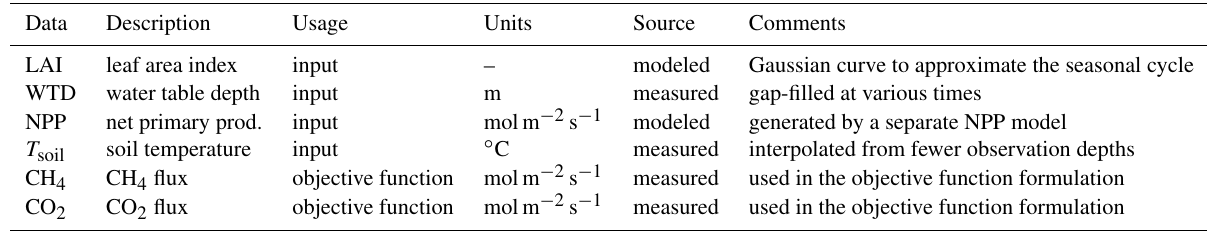
Table 1. Description of the data